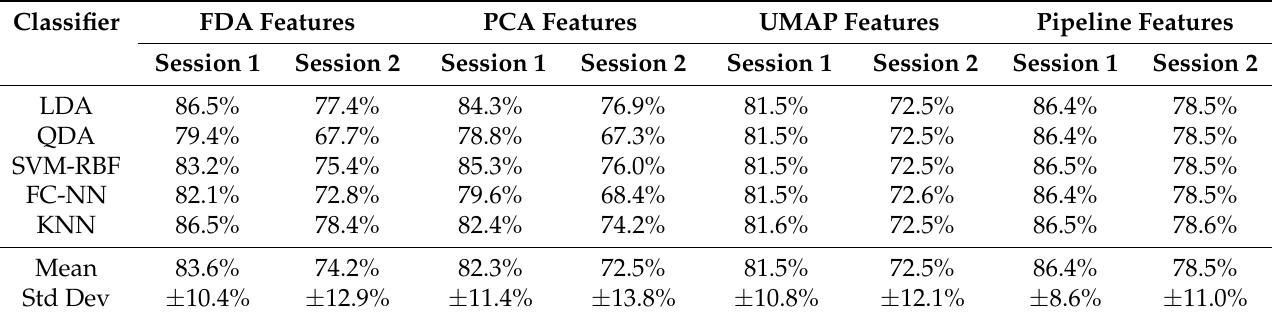
Table 3. Mean accuracy results’ comparison between the pipeline and different features obtained by applying FDA, PCA, and UMAP individually, not sequentially. Classifiers’ results are obtained as a mean of both test sessions of all participants and rounded to 1 decimal